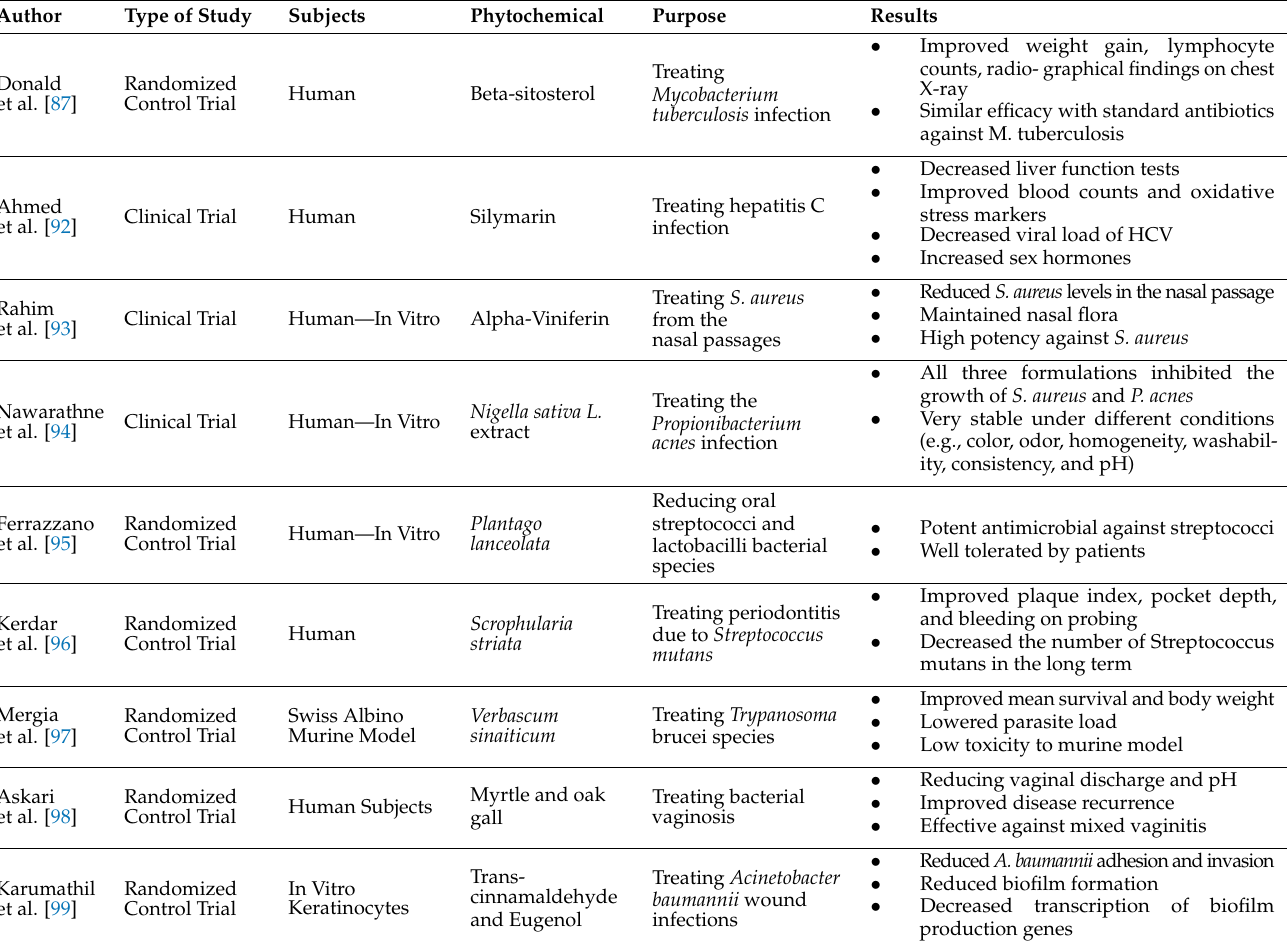
Table 1. Phytochemical clinical trials against